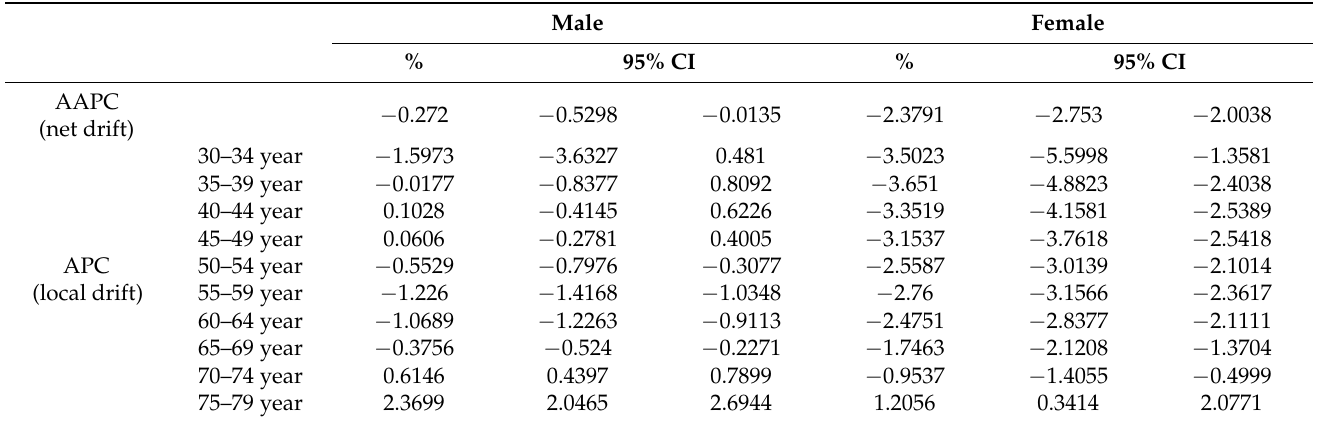
Table 1. Net drift and local drift by age groups of squamous cell lung carcinoma in Taiwan between 1985 and 2019. Male Female % 95% CI % 95% CI